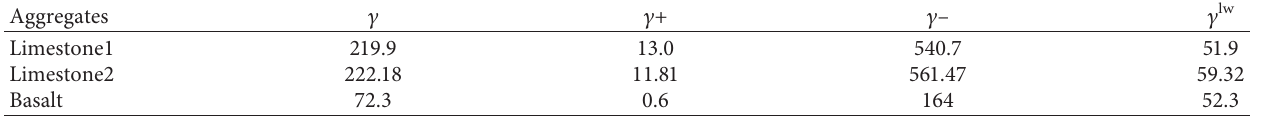
Table 8: SFE components of the